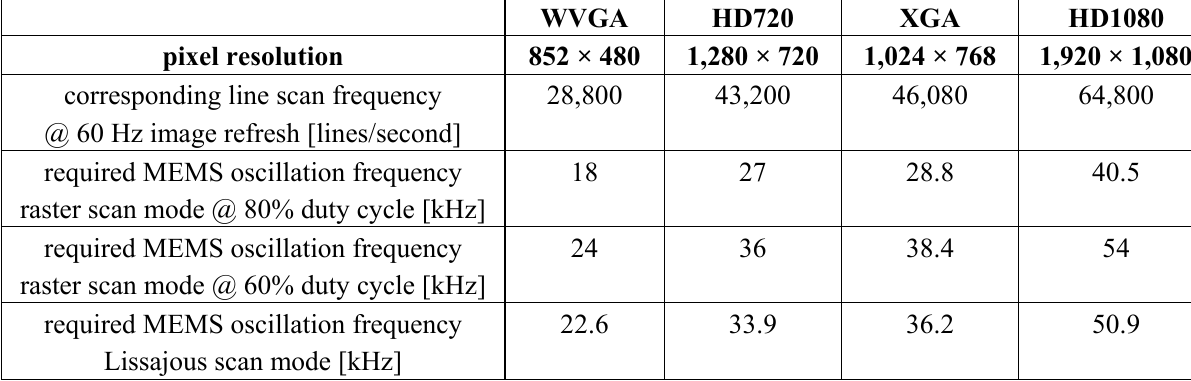
Table 1. MEMS oscillation frequency requirements in a laser projection